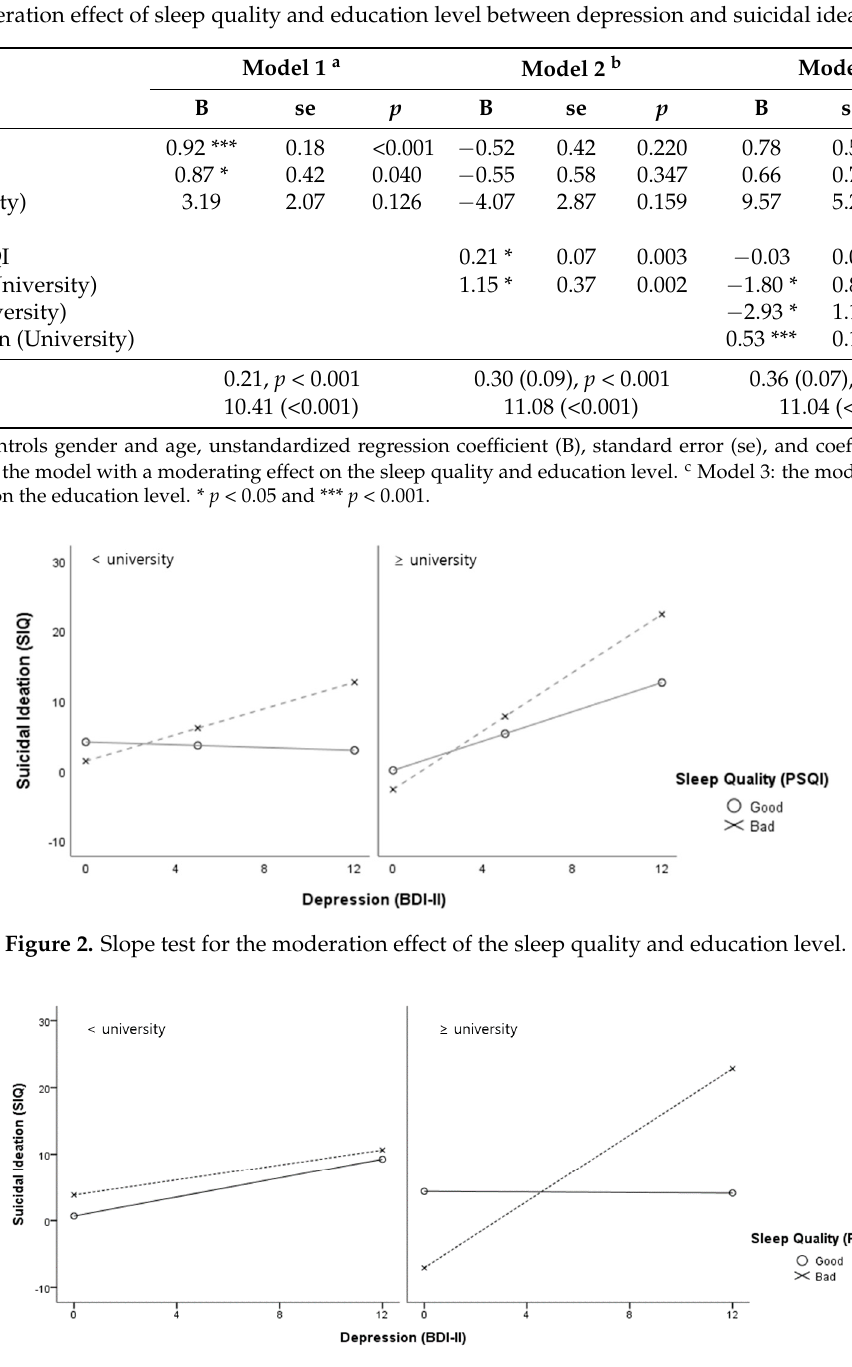
Figure 3. Slope test for the moderated moderation effect of the education level on depression, sleep quality, and suicidal ideations.